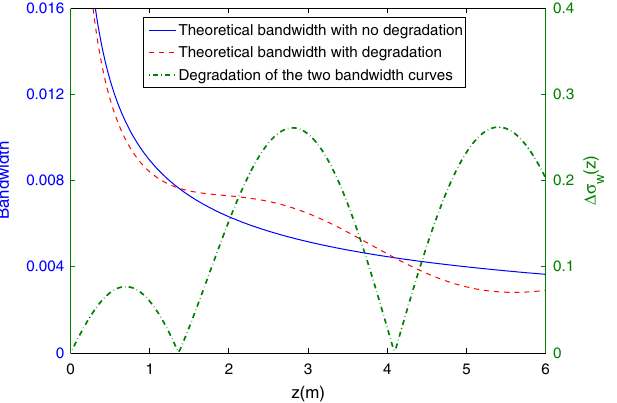
FIG. 1. (Color) Theoretical bandwidth curves and bandwidth degradation. Bandwidth curves are with perfect beam energy and modulated beam energy, respectively. The beam energy modulation for the degraded bandwidth curve is " ¼ 0 : 0024 . The theoretical calculation is based on the pa- (cid:7) m rameters listed in Table